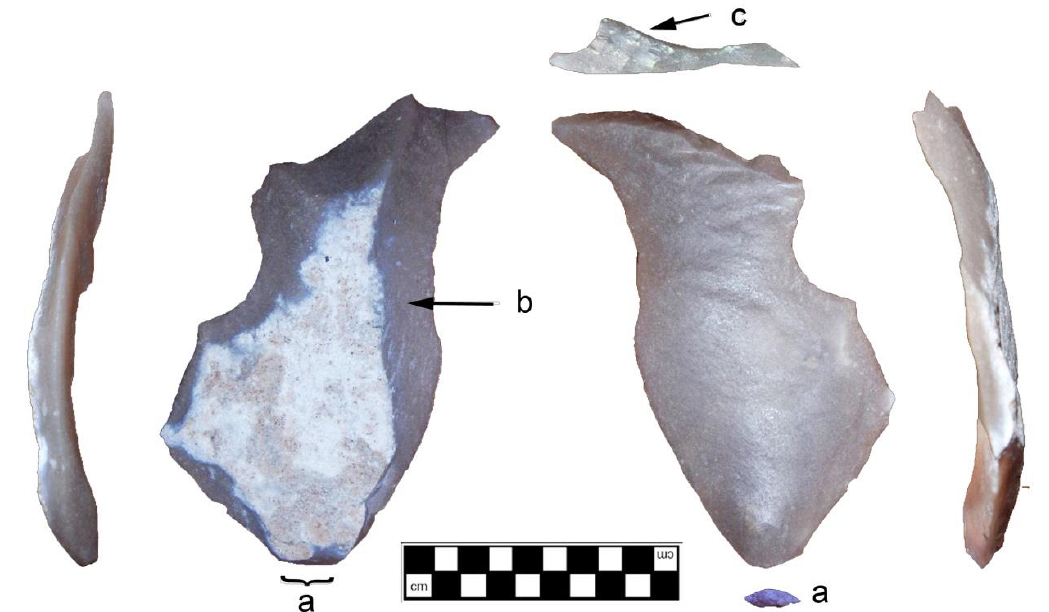
Figure 6. Replica 2 Flake 2 overshot flake. a) prepared platform; b) spacing in relation to previous flake scar; c) margin removed by overshot showing unifacial edge adjustment.